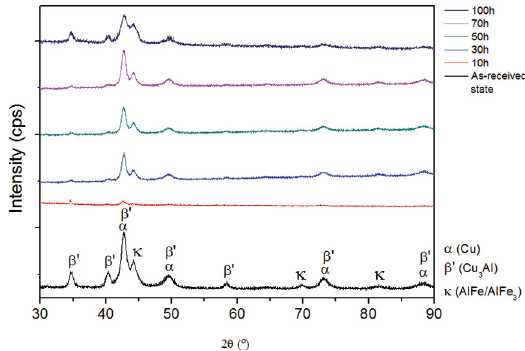
Figure 11. X-ray diffraction and phases of aluminium bronze. Amounts of β’metastable phase were found through the comparison with other studies of XRD 28 . The presence of metastable β’phase in aluminum bronze, termed martensite, is due to preliminar heat treatment TQ-30 (ASM 4590B) that alloy fused receive in aerospace applications in order to increase mechanical properties as tensile strength and hardness 29 .